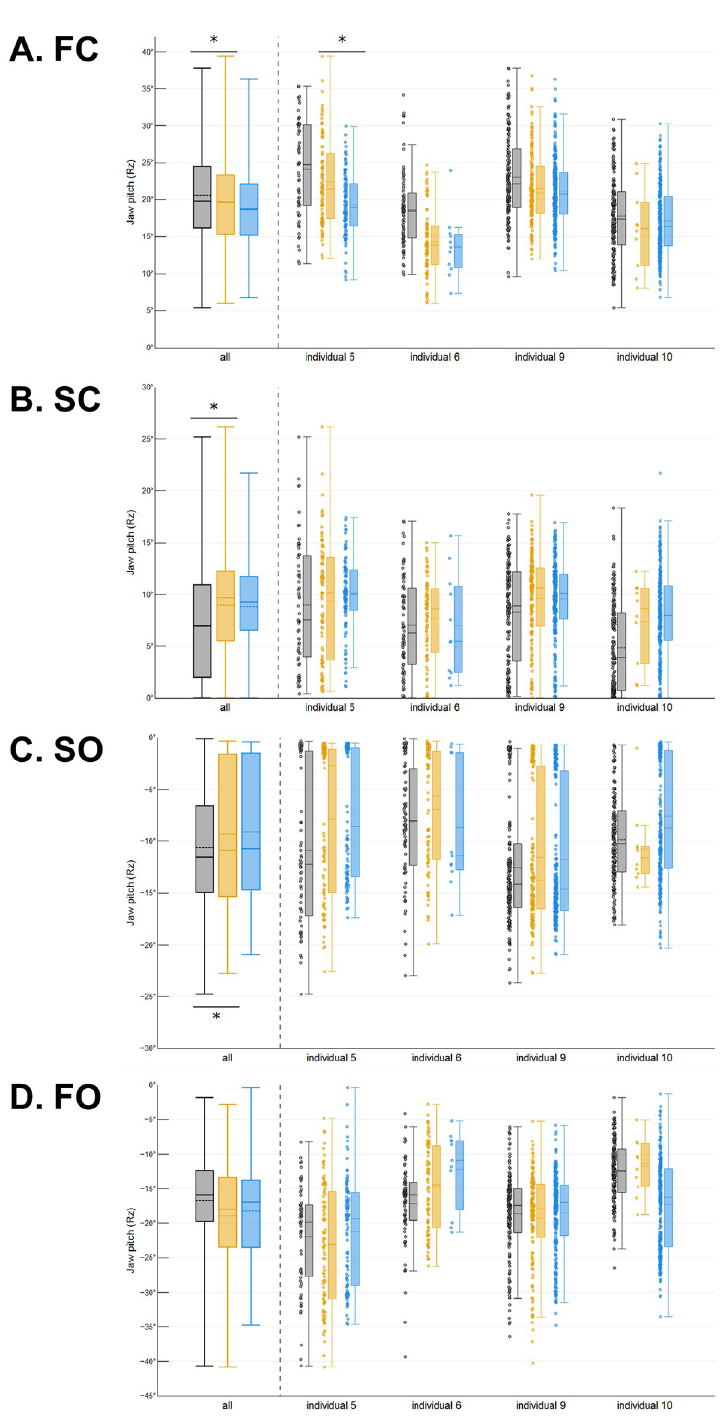
Fig 2. Effect of food toughness and stiffness on the amplitude of jaw pitch (Rz). Plots illustrate the absolute amplitude of jaw closing during each phase of the gape cycle for each food: A ) FC, B ) SC, C ) SO and D ) FO. Colors represent foods: apples in black, carrots in orange and almonds in blue. Each box is defined by the 25 th and 75 th quartiles as its lower and upper limit, respectively. In each box, the solid line is the median, the dashed line is the mean, and whiskers indicate the 5 th and 95 th percentiles. Individual data points are shown next to each box. Significant differences between foods are indicated by an � .